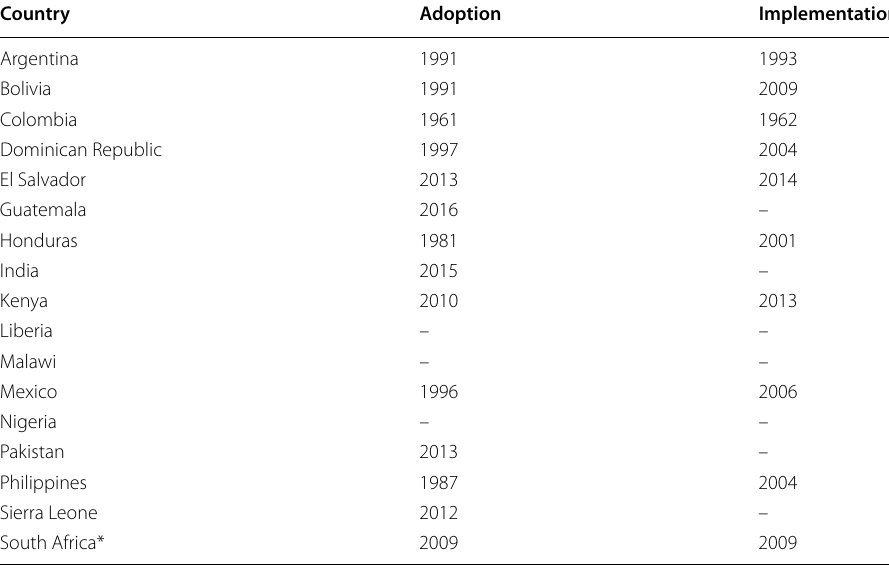
Data from Wellman, Allen and Nyblade (Forthcoming) and reflect adoption and implementation as of 2020 * External voting was originally extended in South Africa in 1993 for the 1994 transitional election, rescinded in 1998, and subsequently re-instated by a constitutional court ruling in 2009 (Wellman, 2021)